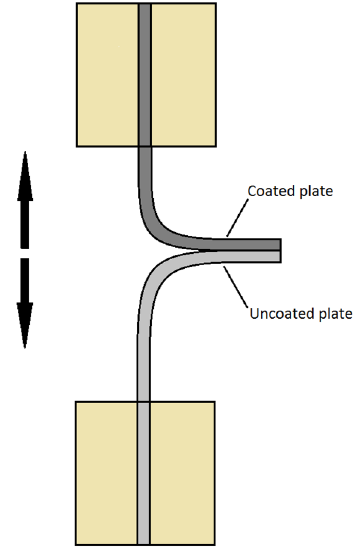
Figure 2. Schematic of the tensile test used.